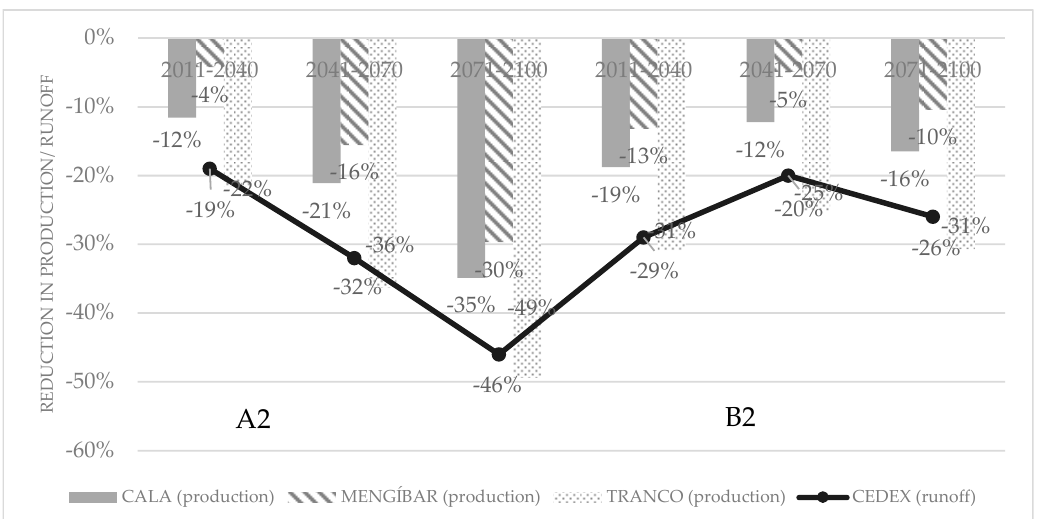
Figure 9. Comparison of projections and climate trends. Source: Own elaboration and CEDEX (2012). As shown above, the decrease in production is higher in plants with greater storage capacity.